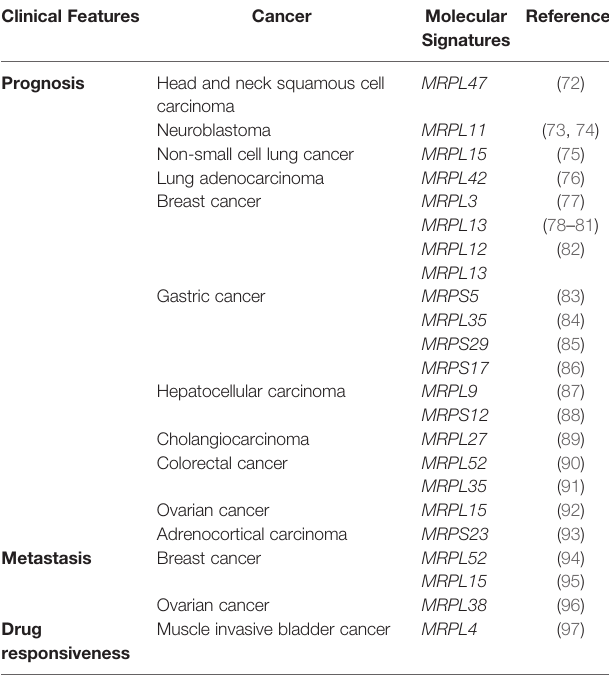
TABLE 2 | Association between mitochondrial ribosomal genes and clinical features of cancer revealed by bioinformatics analyses. Clinical